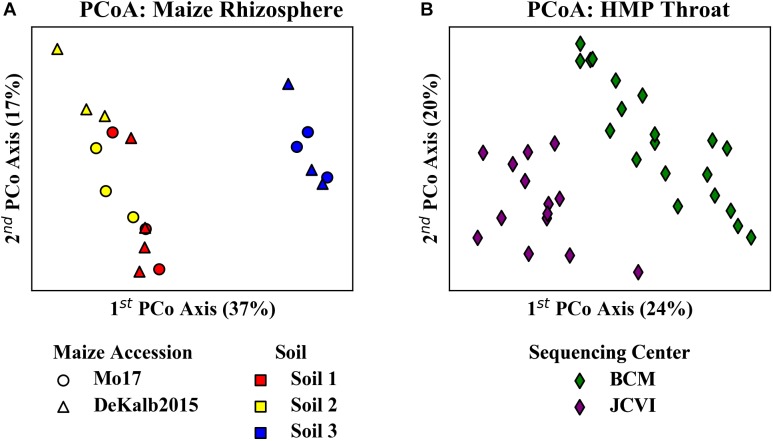
Principal coordinate analysis of (A) rhizosphere microbiome data from two maize accessions grown in three soils and (B) HMP throat microbiome data from two sequencing centers. Analysis is based on 16S-V4 sequences using Bray-Curtis distances. The clear differences in community composition apparent between the different (A) soils and (B) sequencing centers imply that HF occurs between soils.